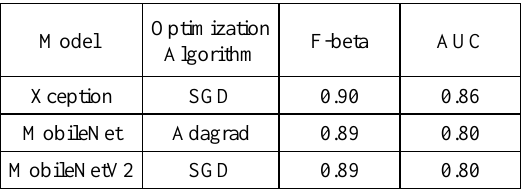
Table 3 . Operation correctness of the best classifiers after the second part of the research.